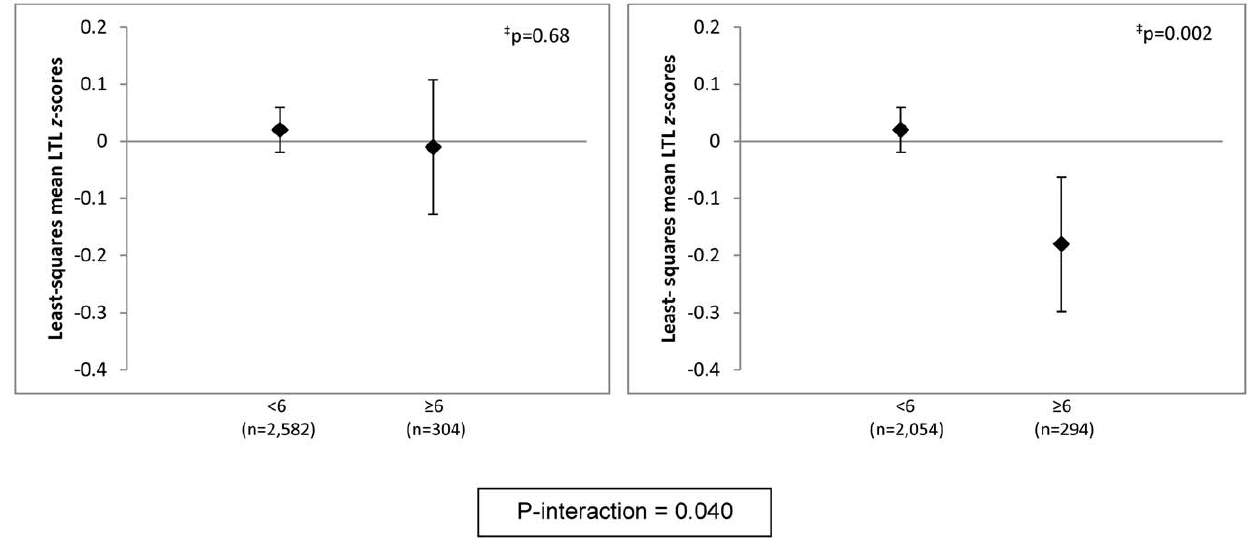
Figure 1. Adjusted* least-squares mean leukocyte telomere length z -scores, by phobic anxiety level, stratified by body mass index ( , 25 kg/m 2 or $ 25 kg/m 2 ). *, Models were adjusted for age in years (continuous), paternal age-at-birth (15–24, 25–29, 30–34, 35–39, $ 40 years), pack-years of smoking (0, . 0 to , 20, 20 to , 40, $ 40), and physical activity (continuous, MET-hrs/wk). Least squares means and 95% confidence intervals are shown. N=9 excluded due to missing body mass index. { , P-value for test of difference in least-squares means.